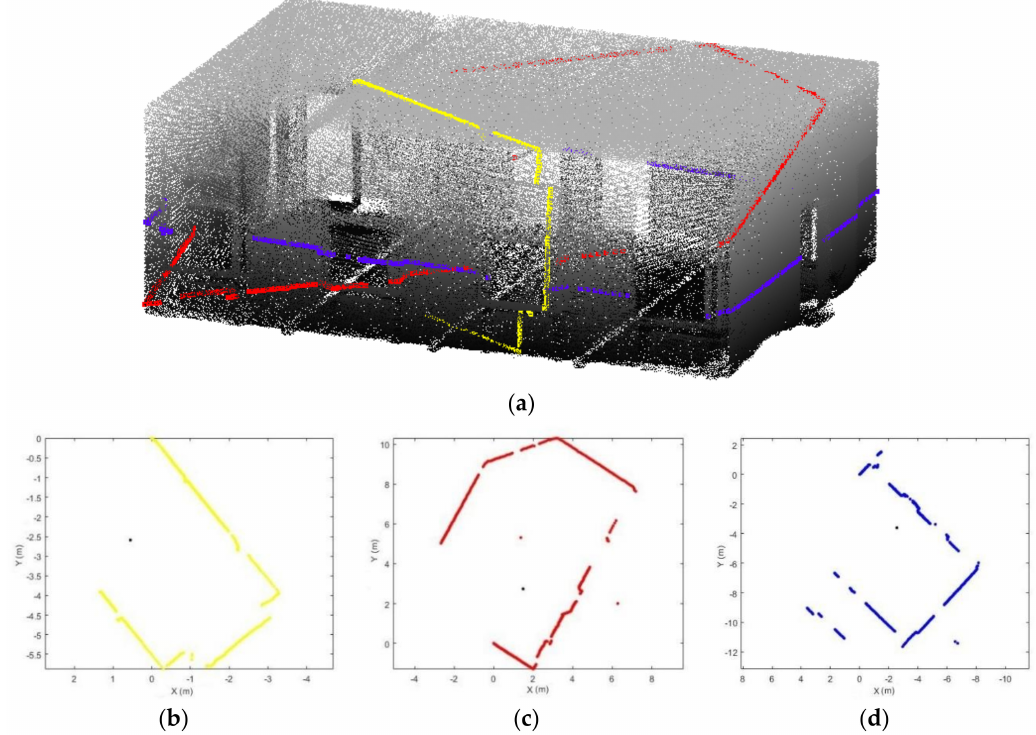
Figure 1. Example scan pattern of three scanlines in a room: ( a ) 3D view of scanlines; ( b – d ) corresponding 2D scanlines (different colour represents different scanlines, black point: scanner